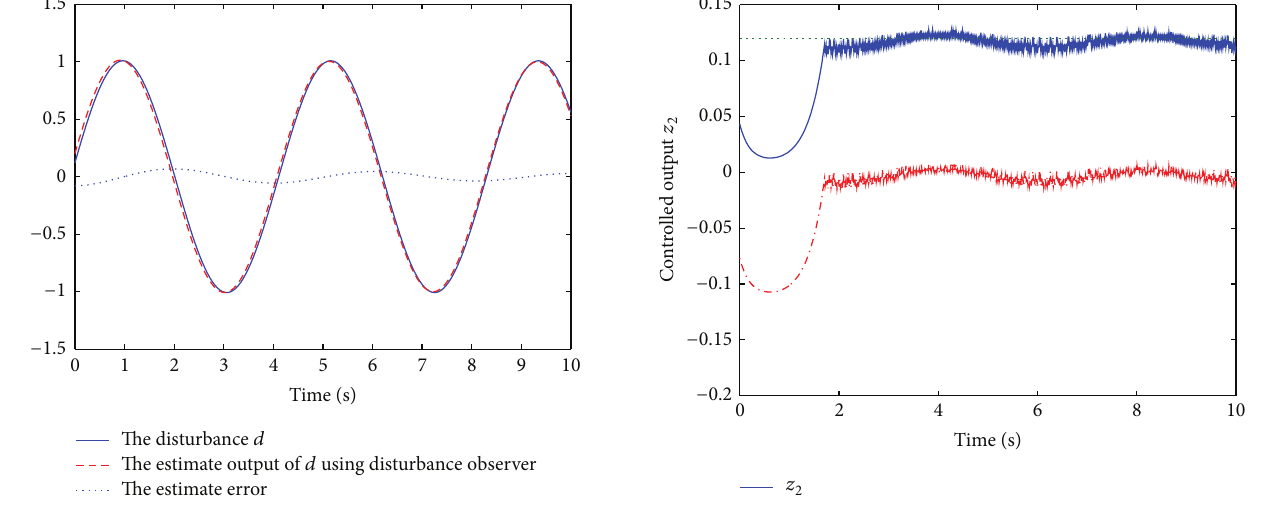
̂ 𝑑 . Figure 3: Controlled output 𝑧 2 and tracking error 𝑒 2 .